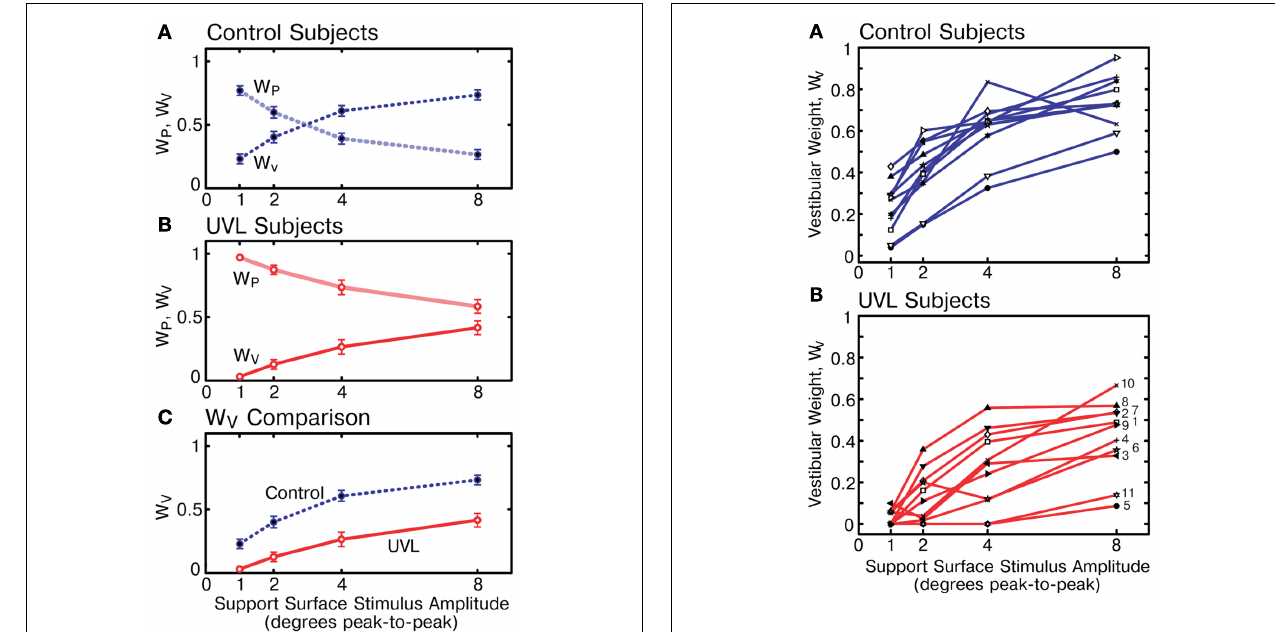
FIGURE 5 |Vestibular weights ( W V ) across stimulus amplitudes for individual control subjects (A) and individual unilateral vestibular loss subjects (B). Numbers labeling W V data of unilateral loss subjects correspond to labels in Table 1